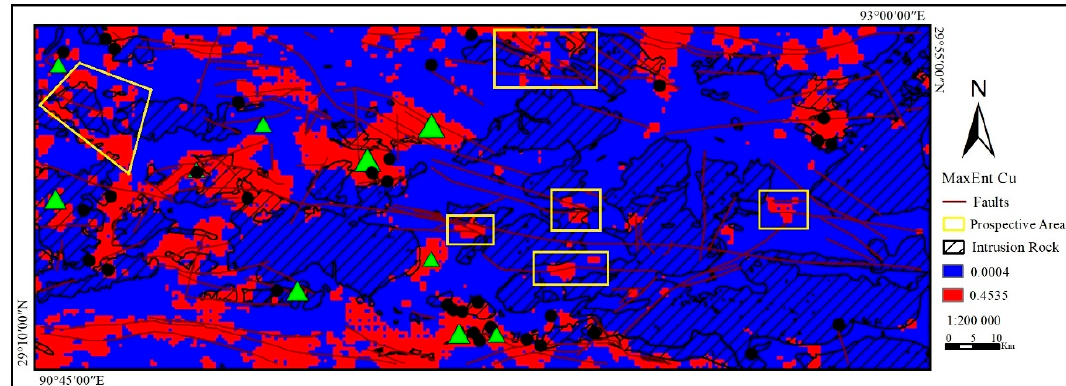
Figure 13. Prospective area: Areas delineated with rectangles represent targets likely related to mineralization and should be further investigated with more information.